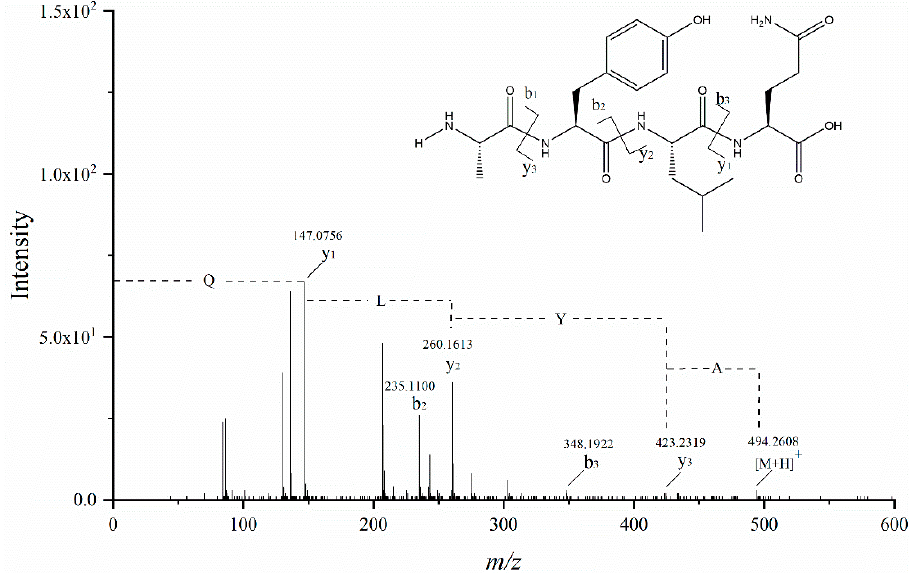
Figure 6. MS/MS spectrum of the peptide ( m/z = 494.2608) in a single charge mode. Figure 6. MS / MS spectrum of the peptide ( m / z = 494.2608) in a single charge mode.